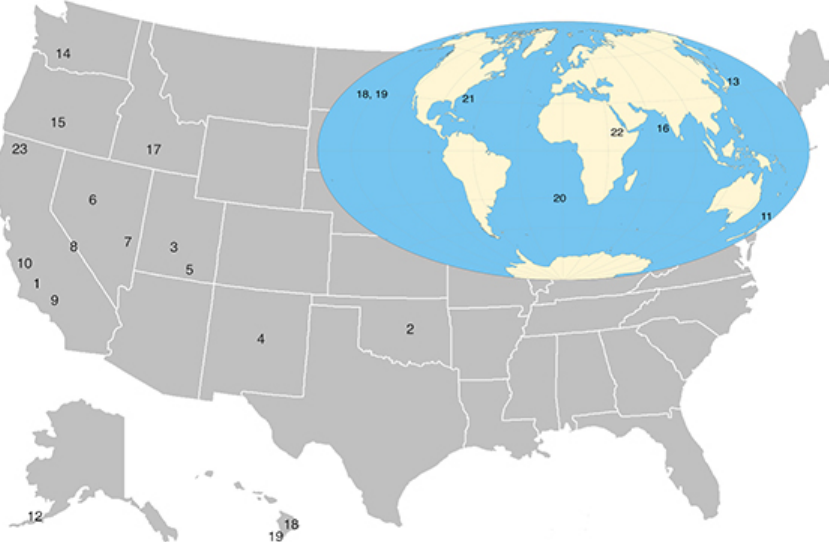
Figure 1. Map of USA and inset map of the world with recommended projects and alternate projects marked (Table 2). Projects 1–11 relate to fault zone drilling, projects 12–15 to active volcanic systems, and projects 16–23 to chemical